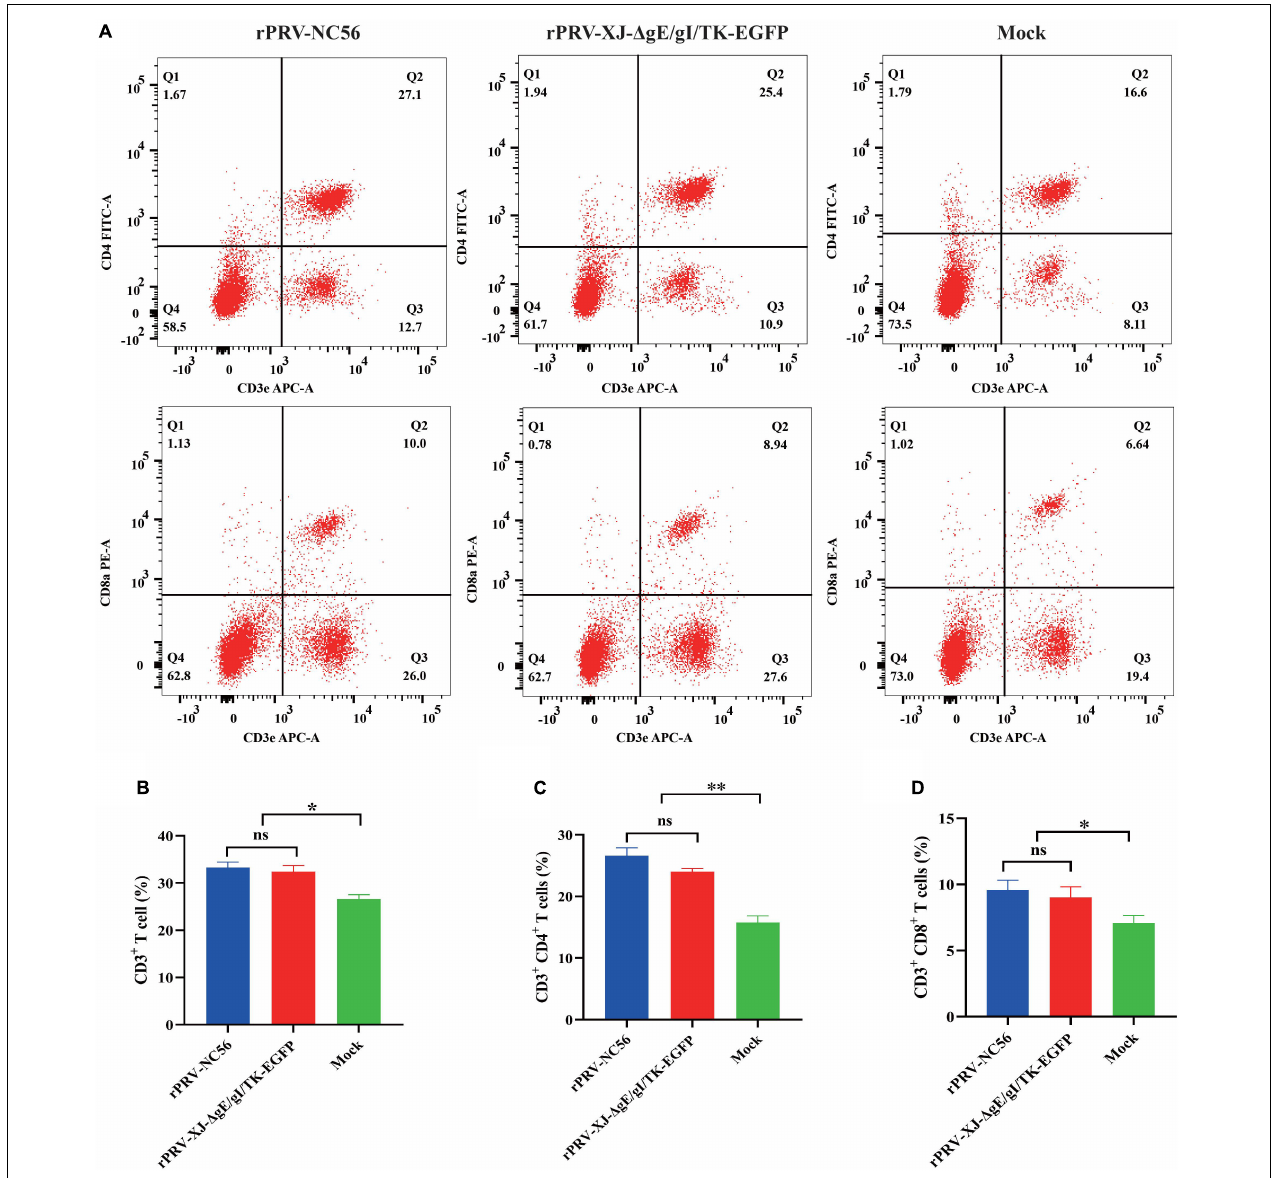
FIGURE 9 | Flow cytometric analysis of CD3 + /CD4 + /CD8 + cells in the spleen of rPRV XJ- (cid:49) gE/gI/TK-EGFP, rPRV-NC56, and nonvaccinated groups. (A) Flow cytometry analysis of CD3 + , CD3 + CD4 + , and CD3 + CD8 + T-cell populations at 2 weeks postvaccination (wpv) after immunization ( n = 6/each group). The data show the percentage of CD3 + (B) , CD3 + CD4 + (C) , and CD3 + CD8 + (D) T cells in the total splenocytes. By GraphPad Prism 5.0, unpaired t -test, ∗ p < 0.05; ∗∗ p < 0.01; ∗∗∗ p < 0.005; and ∗∗∗∗ p <